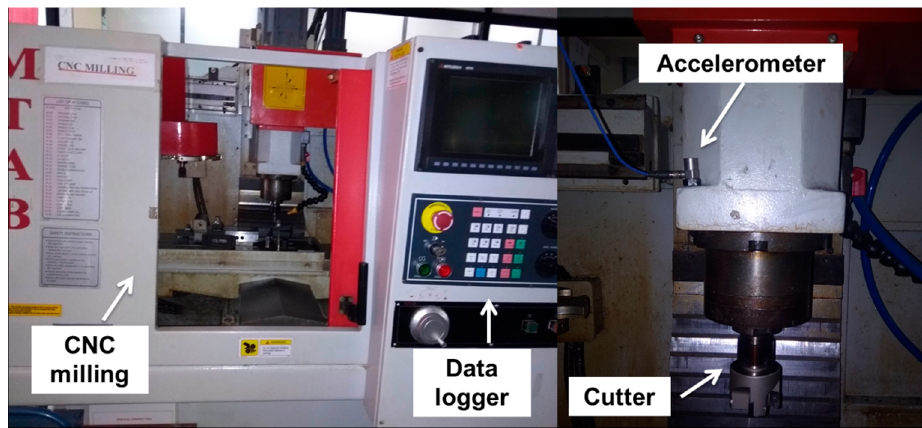
Figure 2. The schematic of the experimentation arrangement.